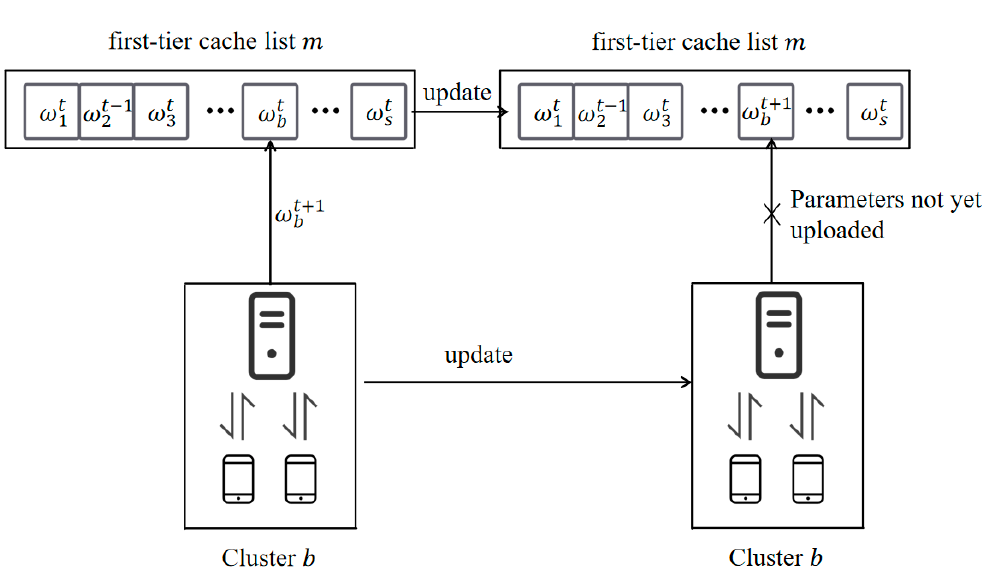
Figure 3. Update principle of the second-tier cache. The second-tier cache sends the model to cluster 𝑏 using a random distribution.